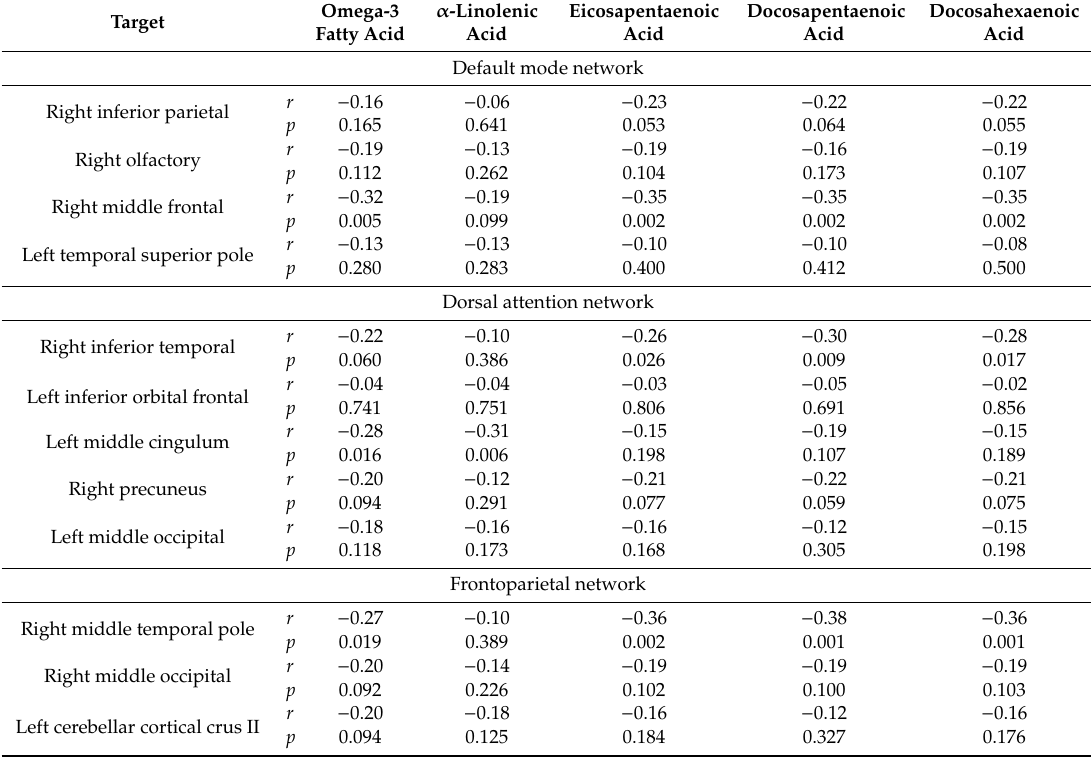
Table 4. The correlation between the regions related to depression and omega-3 fatty acid intake among the